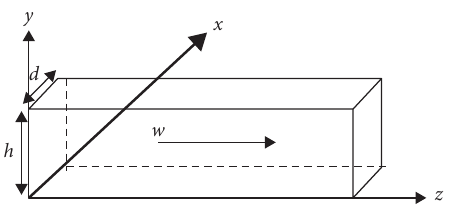
Figure 1: Flow through rectangular duct.